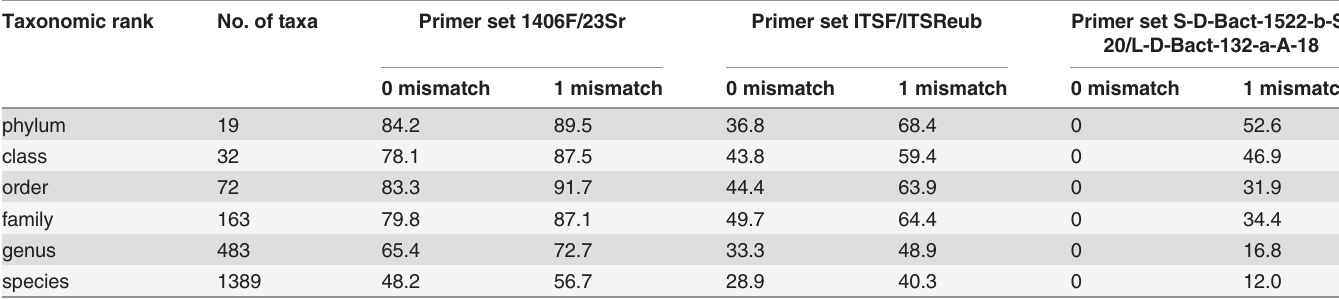
Table 1. Proportion of bacterial taxa with positive virtual ampli fi cation in the wgs-embl-pro database revealed by ecoPCR. Taxonomic